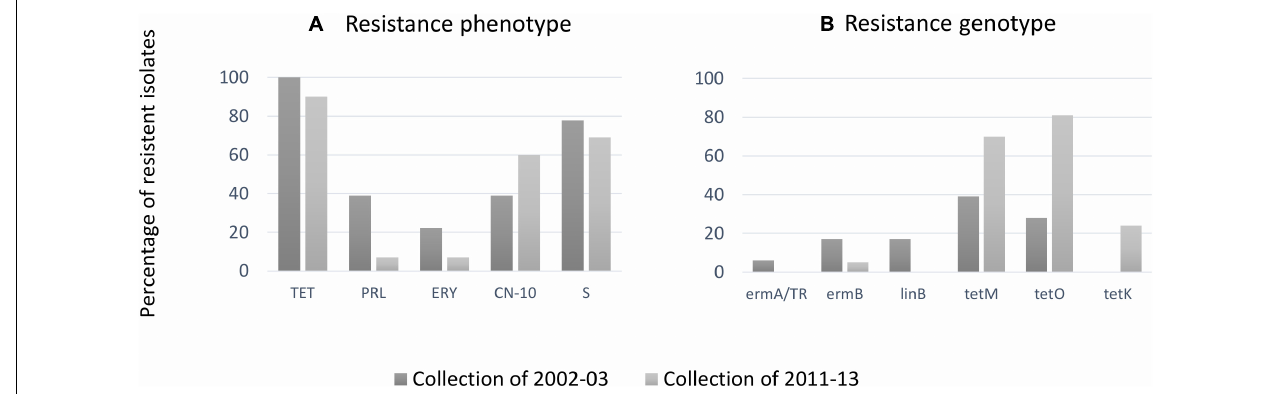
FIGURE 4 | (A) Percentages of antimicrobial resistance among bovine Streptococcus dysgalactiae subsp. dysgalactiae (SDSD) isolates from the present study against erythromycin (ERY), gentamicin (CN), pirlimycin (PRL), streptomycin (S), and tetracycline (TET). Resistance was not observed against amoxicillin–clavulanic acid (AMC), cefazolin (KZ), chloramphenicol (CHL), penicillin (P), rifaximin (RAX), and vancomycin (VA). (B) Distribution resistance genotypes among bovine SDSD: ermA and ermB : macrolide resistance genes; linB : lincosamide resistance gene; tetK , tetM , and tetO : resistance to tetracycline genes. The statistical significance of the data was determined by a chi-square test ( χ 2 ), where a probability value ( p ) ≤ 0.05 was considered as statistically